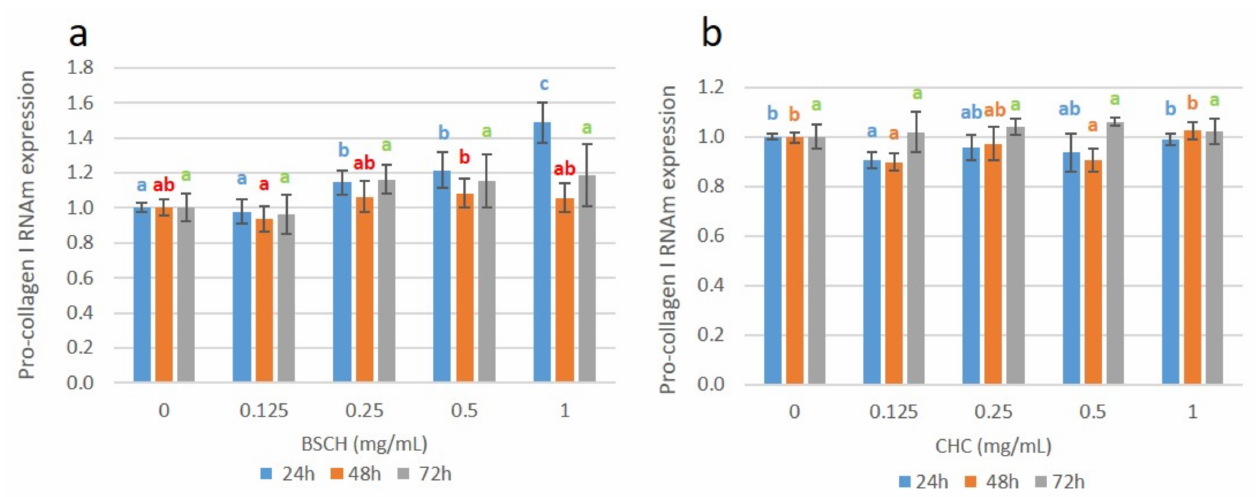
Figure 5. Pro-collagen I RNAm expression for the fibroblast cell cultures treated with BSCH-C ( a ) and CHC ( b ) hydrolysates and normalized to the control group. Values are shown as means with standard deviation. Different letters indicate significant differences between concentration groups ( p <